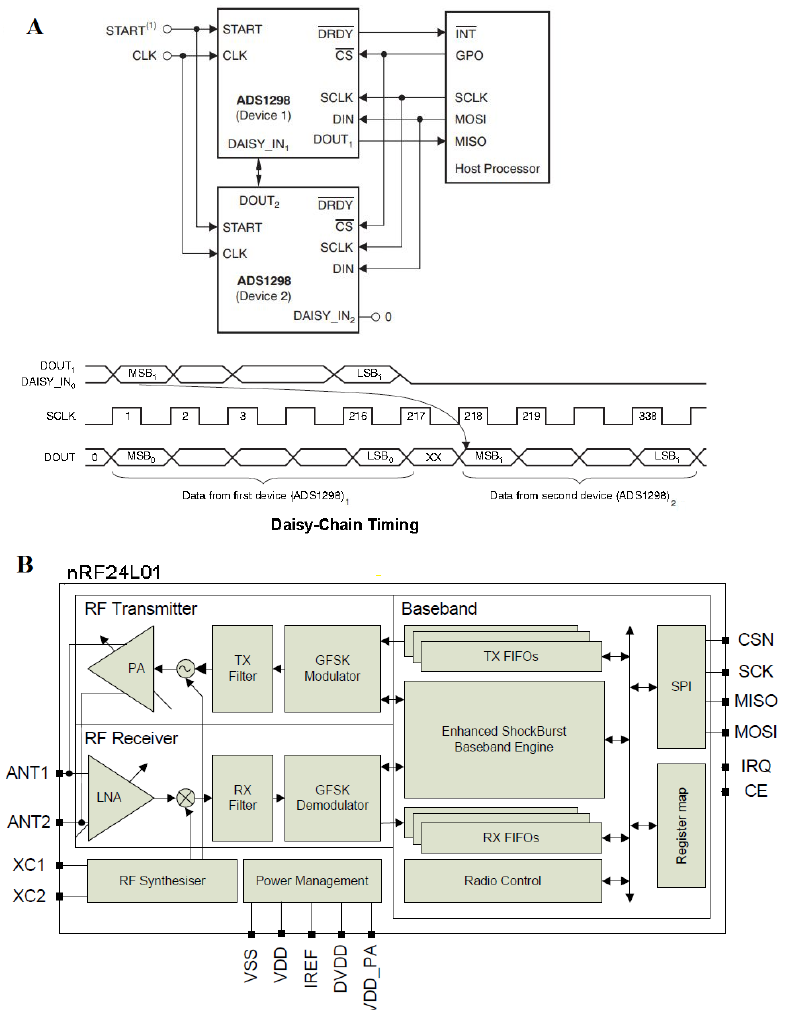
Figure A2. ( A ) Daisy chain configuration with two devices. In this configuration, SCLK, DIN, and CS are shared across multiple devices. The DOUT pin of device 2 is connected to the DAISY_IN pin of the first device, creating a chain. The DRDY pin of the first AFE is connected with the microcontroller, and the DRDY pins of other boards do not need to be connected. All devices are configured to the same register values because CS is shared and connected to SCLK, MOSI, MISO, and the general-purpose digital outputs (GPOs) of the microcontroller and those of the wireless connection transmitter. The devices in the chain operate in the same register setting. DIN can be shared, thereby reducing the SPI communications. ( B ) nRF2401. The FIFO data store the transmitted (TX FIFO) or received payloads ready for shutdown (RX FIFO). Both modes (PTX and PRX) allow the FIFOs access. Both FIFOs have a controller and are accessible through the SPI by special serial peripheral interface commands.